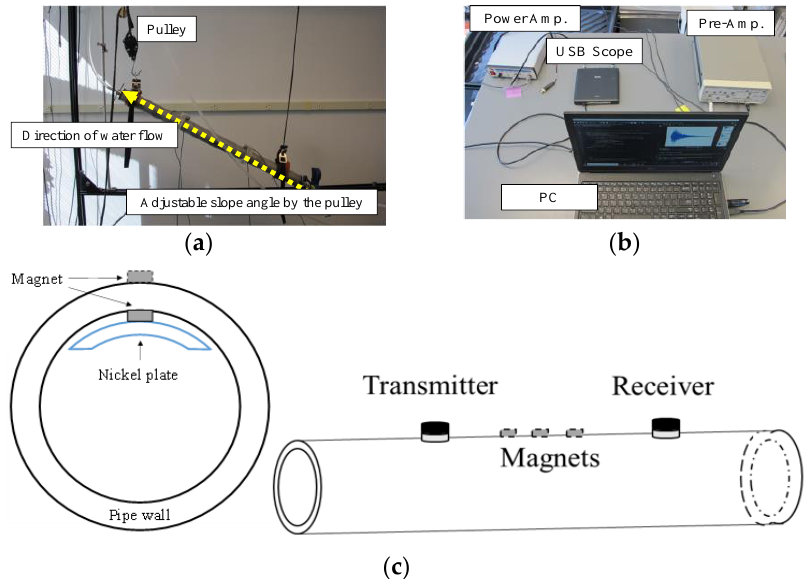
Figure 5. Experimental setup for multi-mode ultrasonic signal measurement using adjustable tilt angle ( a ); electronics for multi-mode ultrasonic measurements ( b ); and cross-section of stainless- steel pipe ( c ): Nickel plate is used as a holder of inner magnets. The magnets drawn with a solid line stay on the inner surface of the pipe, keeping their initial locations. The magnets shown with a dashed line are attached on the outer surface to simulate mechanical